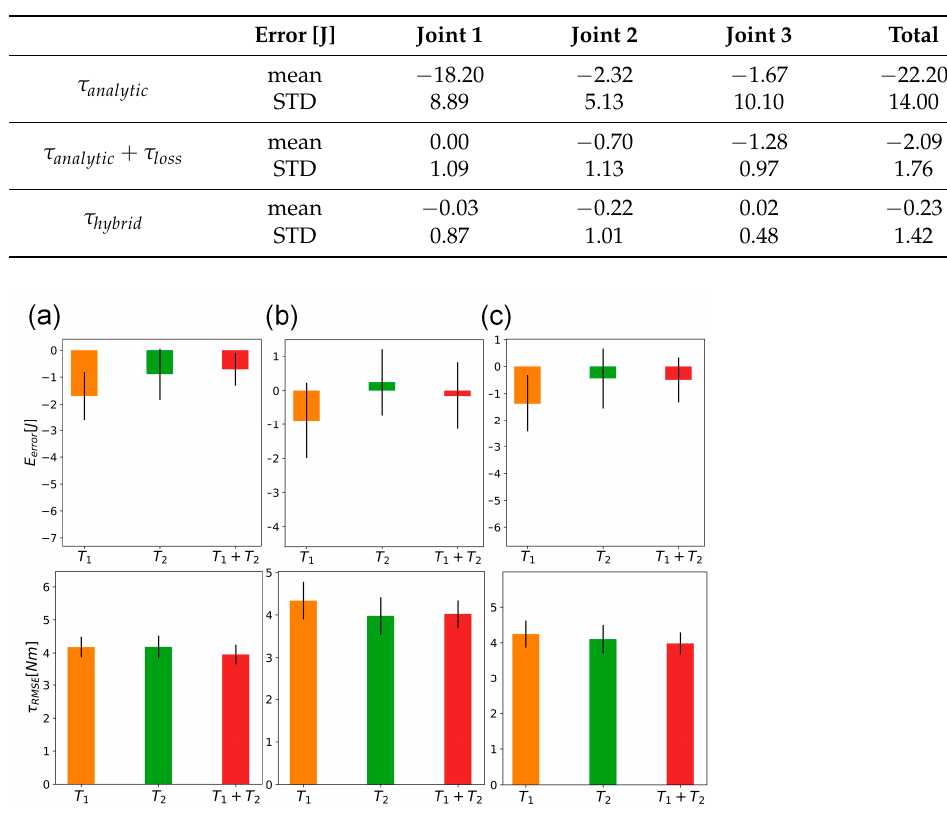
Table 1. The energy consumption discrepancy between the empirical manipulator and the models with different compensation terms.